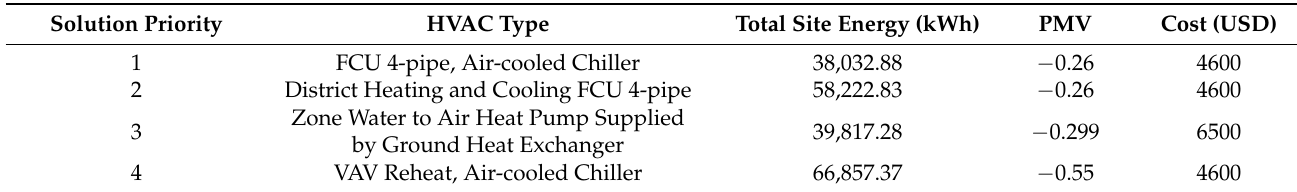
Table 6. HVAC systems used in current weather conditions.